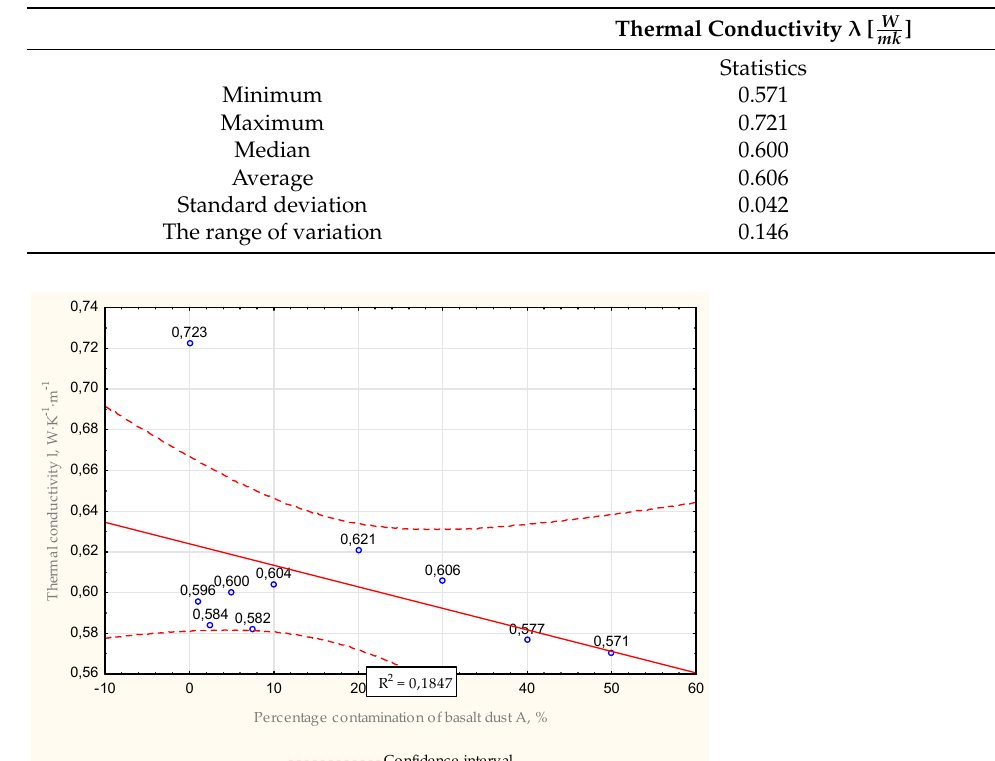
about 21% lower than that of the zero sample. For remaining grout mixtures, values were lower by about 14% to 20%.